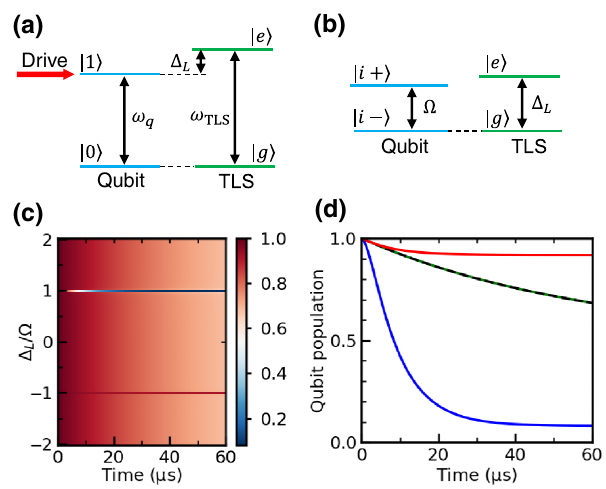
FIG. 1. (a),(b) Energy level diagrams of a qubit and an off- resonant charge-fluctuation TLS defect in the (a) laboratory frame and (b) rotating frame for (cid:11) L > 0. (c),(d) Results of numerical simulations of the system evolution for a given Rabi frequency. (c) Population of the excited qubit state | i +(cid:7) in the rotating frame as a function of the evolution time and qubit- defect detuning. The qubit is dynamically coupled to the defect when the condition given by Eq. (25) is met. (d) Qubit population at the qubit-defect detunings (cid:11) L = (cid:10) (blue line), (cid:11) L = − (cid:10) (red line), and (cid:11) L (cid:8)= ± (cid:10) (green line). The dashed black line corre- sponds to the exponential decay f ( t ) = [1 + exp ( − (cid:12) 1 q t / 2 ) ] / 2. In the {| i −(cid:7) , | i +(cid:7)} eigenstate basis, the system